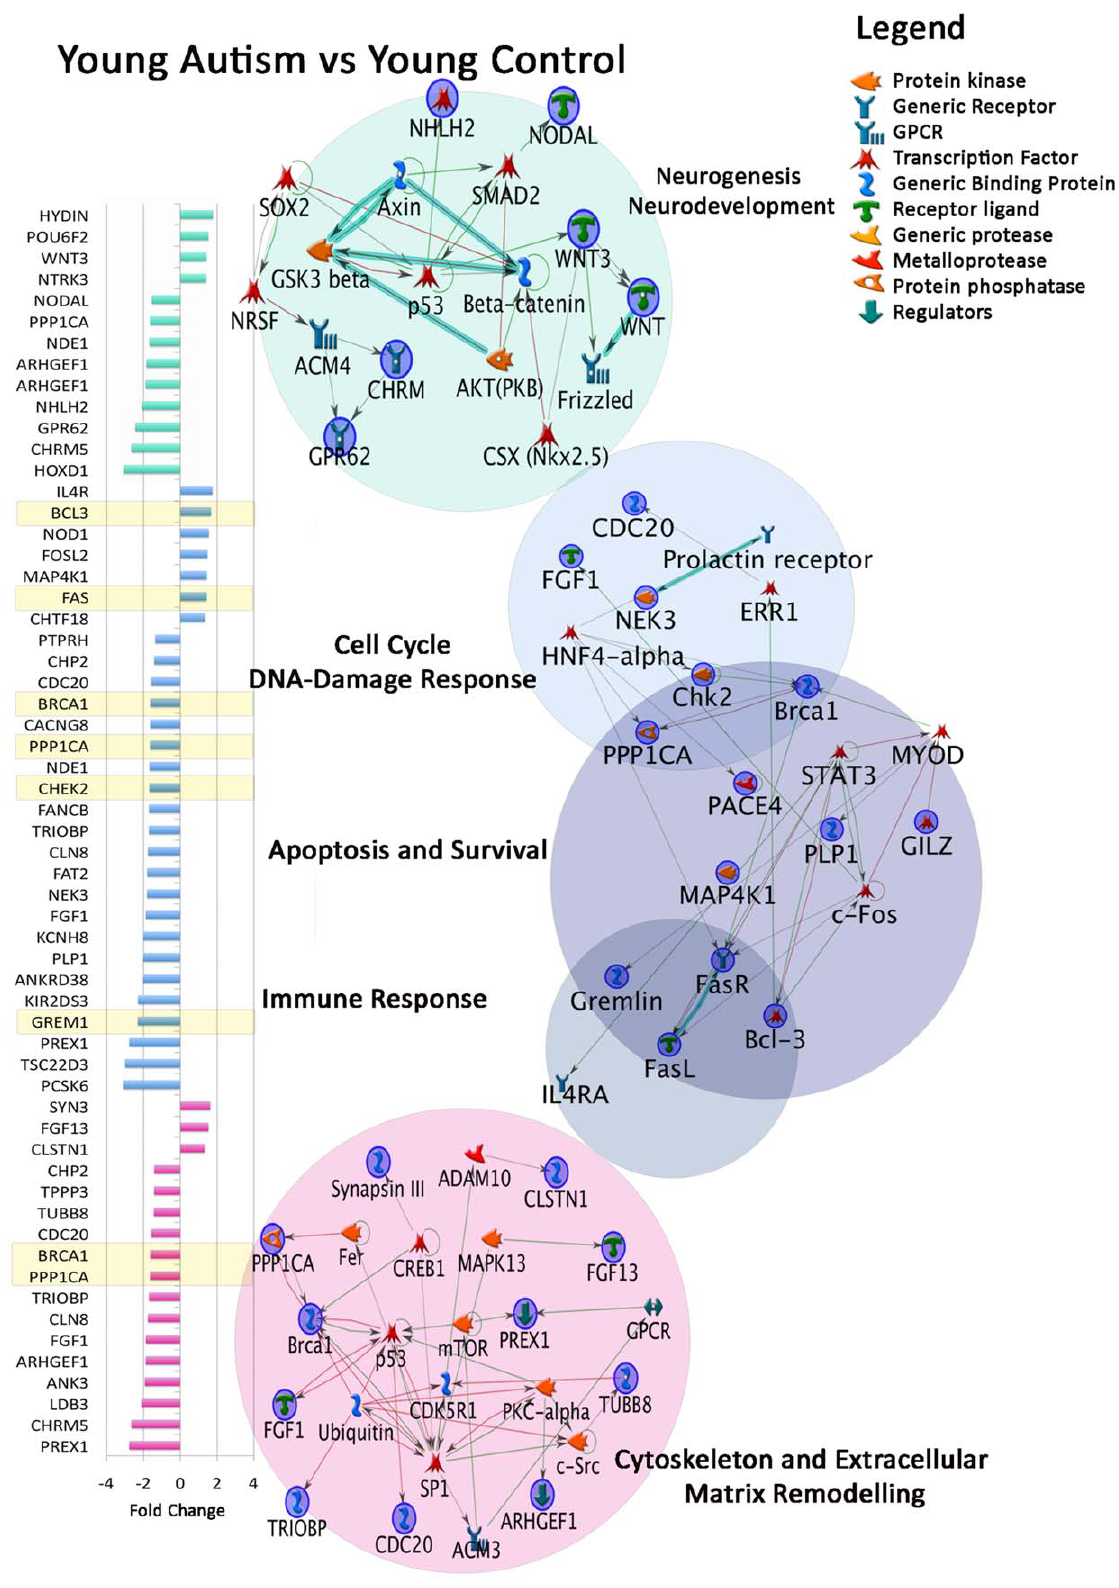
Figure 1. Dysregulated gene expression in developmental M-Pathways and Process Networks in young autistic prefrontal cortex. From differentially expressed genes of young autistic vs. young control cases (Table S2), networks were created using MetaCore Network Analysis. Colors on fold change graph correspond to circles on the right depicting network maps in each category. Yellow=differentially expressed genes in two or more functional domains. Overlapping circles=differentially expressed genes common to two domains. doi:10.1371/journal.pgen.1002592.g001 PLoS Genetics | www.plosgenetics.org